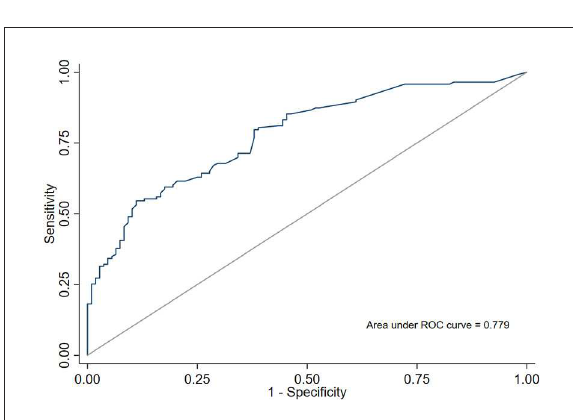
FIGURE2 ROC curve and area under receiver operating characteristic curve (AUC) of a predictive model for fall risk in elderly patients with visual